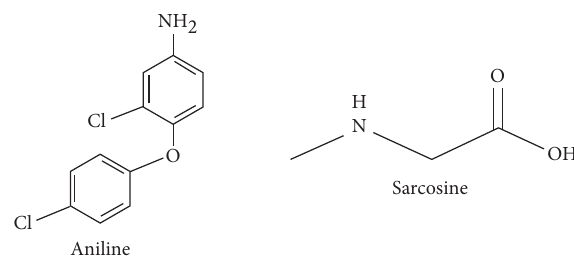
Figure 2: Structure of aniline and